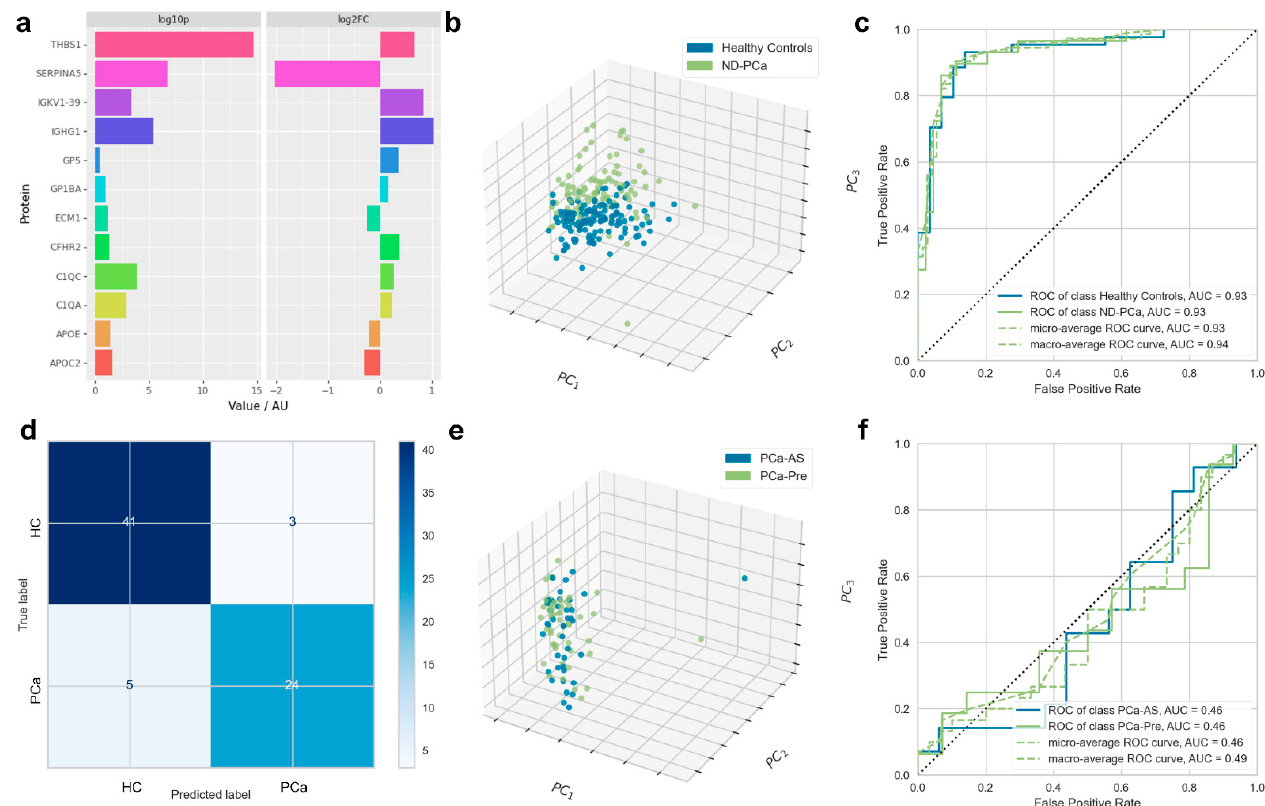
Figure 1. Panel of twelve serum protein biomarkers discriminating newly diagnosed prostate cancer patients and healthy controls. Biomarkers segregating healthy controls (HC) from newly diagnosed prostate cancer patients (PCa-ND) (composed of individuals put on active surveillance or requiring immediate treatment at time of diagnosis) were characterised by random forest analysis; with clas- sification models constructed by logistic regression. ( a ) Significance ( − log 10 ( p V)) and expression fold change (log 2 (FC)) of biomarkers differentiating between HC and PCa-ND. ( b ) Principal component analysis (PCA) showing the degree of separation between HC and PCa-ND. The PCA axes show the first, second, and third most important directions in the reduced space along which the samples show the largest variation. ( c ) AUC for test set only showing individual ROC curves for HC and ND-PCa participant classification. ( d ) Confusion matrix for linear regression model applied to PCa versus HC participants. ( e ) The degree of separation between PCa-Pre and PCa-AS. ( f ) AUC for test set only showing individual ROC curves for PCa-Pre and PCa-AS participant classification.